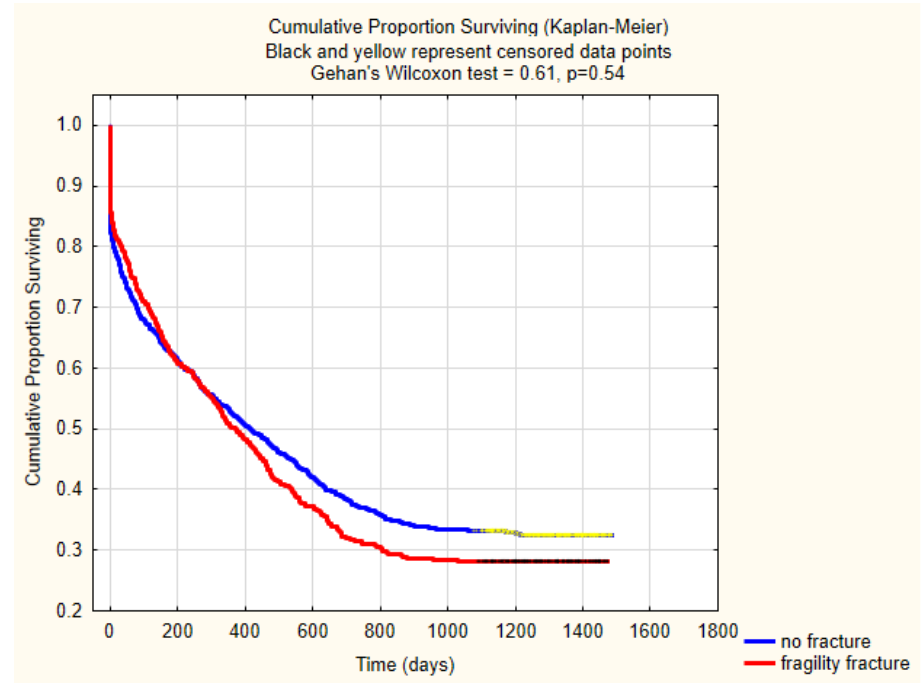
Figure 4. Kaplan–Meier graph showing mortality trends between no fracture and fragility fracture group.